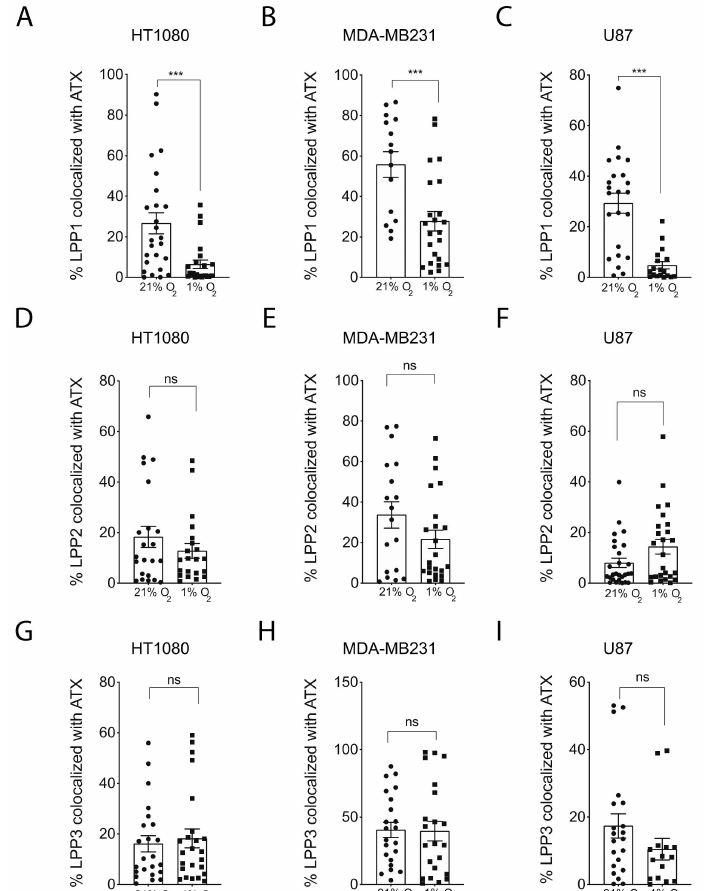
Figure6. Quantificationoftheco-localizationofATXandLPPsunderhypoxicconditions. Quantification of the percentage of ( A – C ) LPP1, ( D – F ) LPP2, or ( G – I ) LPP3 co-localized with ATX in ( A , D , G ) HT1080, ( B , E , H ) MDA-MB231 or ( C , F , I ) U87 cells cultured on non-fluorescent gelatin for 4 h in normoxia (21% O 2 ) or hypoxia (1% O 2 ). Bars represent the mean ± SEM (*** p < 0.001, ns =